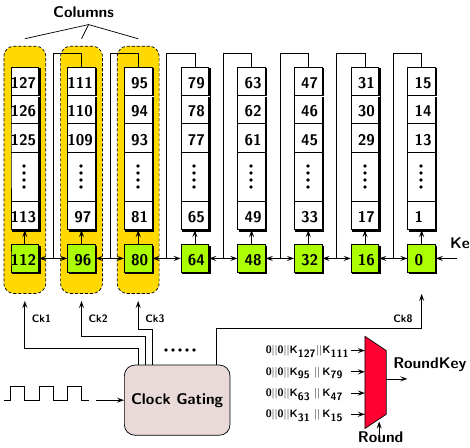
Figure 9: GIFT key schedule